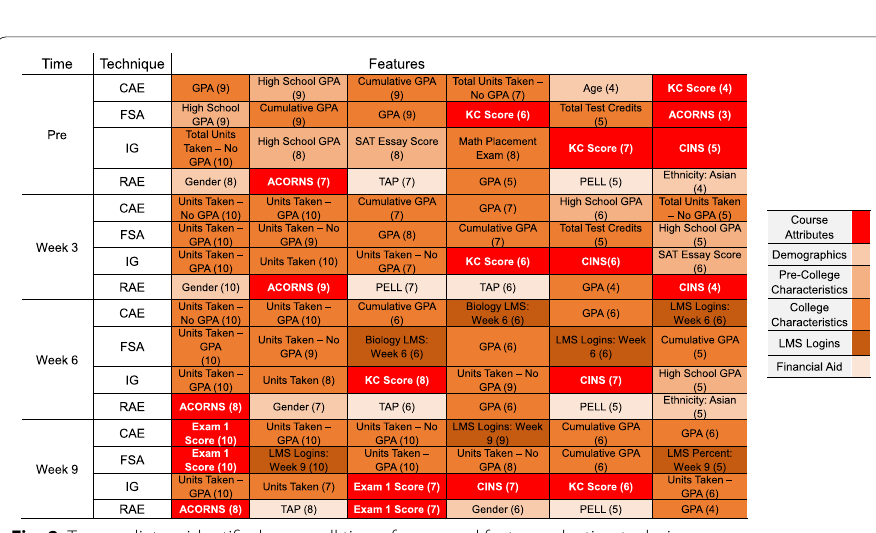
Fig. 8 Top predictors identified across all times frames and feature selection